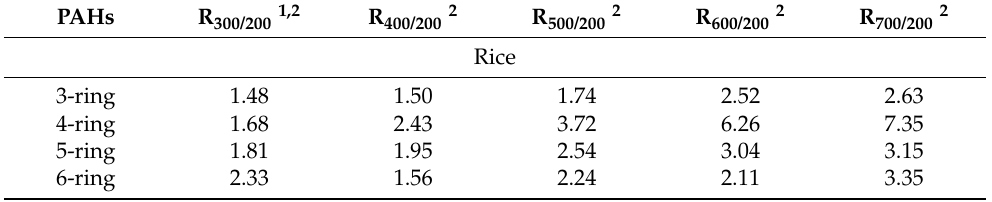
Table 12. Relative changes in PAH composition from rice and bean burning at different